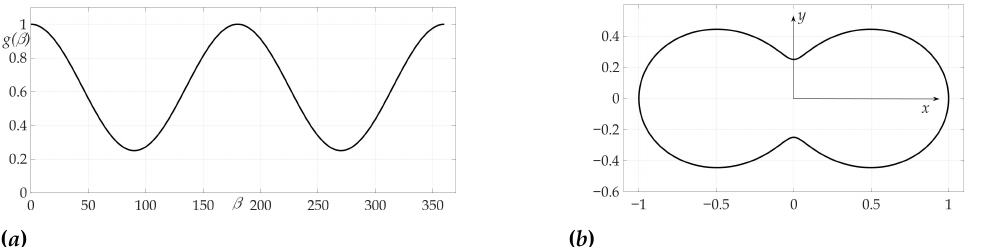
Figure 4. Radiation pattern as an dependence g ( β ) in polar coordinates ( a ) and on the Cartesian plane ( b ).